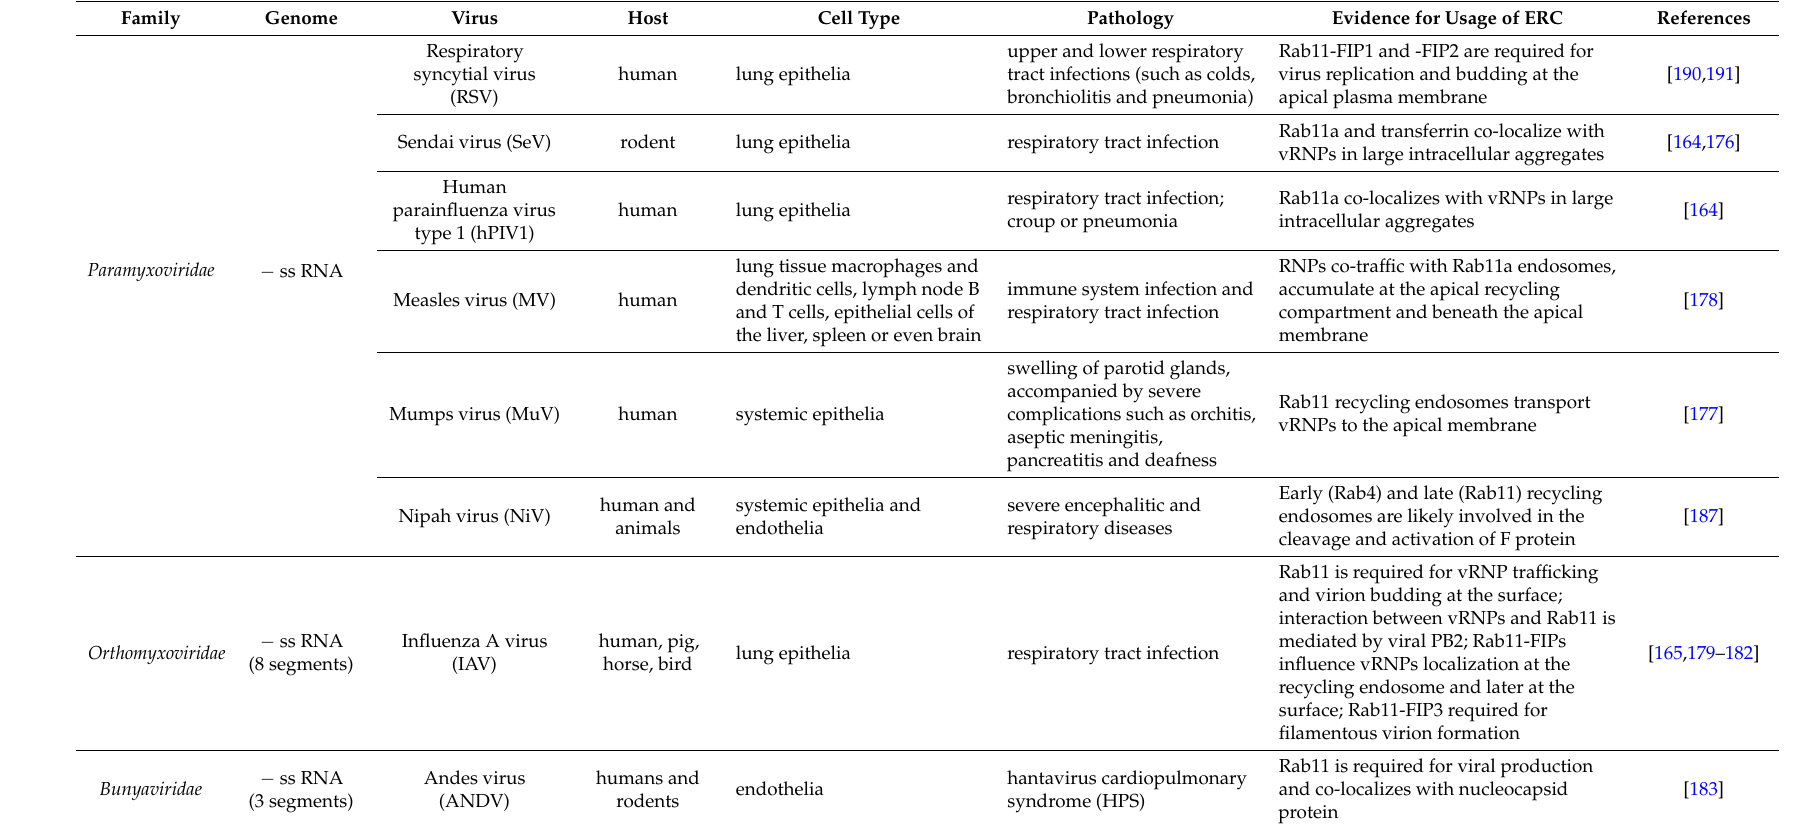
Table 3. Evidence for viral usage of the ERC at assembly and budding